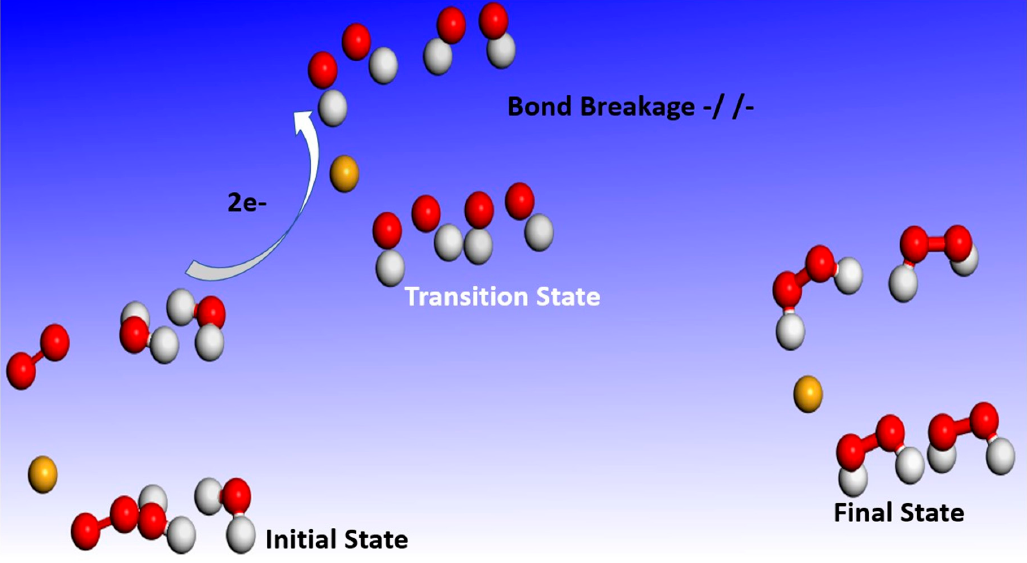
Figure 5. Doubly-charged anionic transition state geometry optimization for Pu. The red, white, and gold spheres represent O 2 , H 2 and Pu (catalyst), respectively. Note the broken bonds in the transition state.